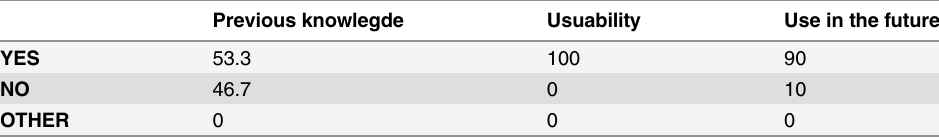
Table 7. Percentages relating to the clinical assessment